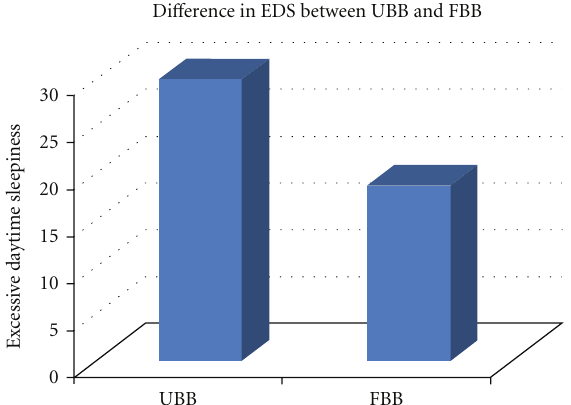
Figure 1: Illustration of difference in excessive daytime sleepiness between US-born blacks and foreign-born blacks ( 𝜒 2 = 12.61 , 𝑃 < 0.001